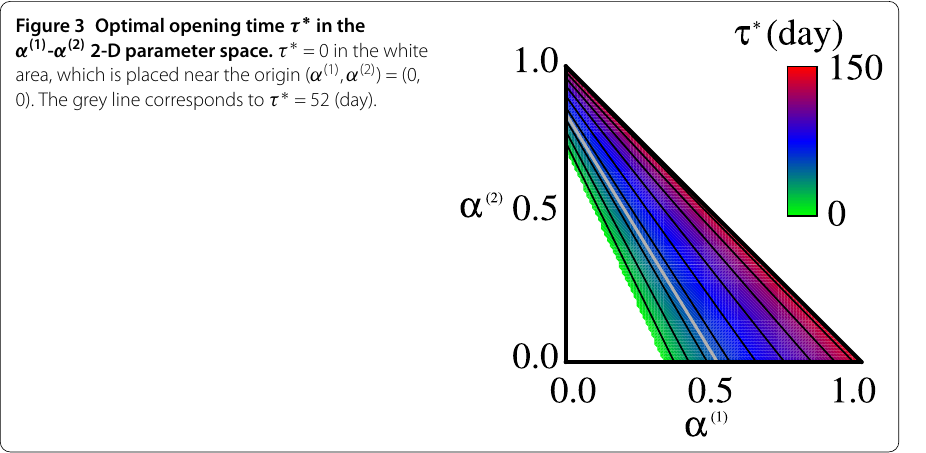
Figure 3 Optimal opening time τ ∗ in the α (1) - α (2) 2-D parameter space. τ ∗ = 0 in the white area, which is placed near the origin ( α (1) , α (2) ) = (0, 0). The grey line corresponds to τ ∗ = 52